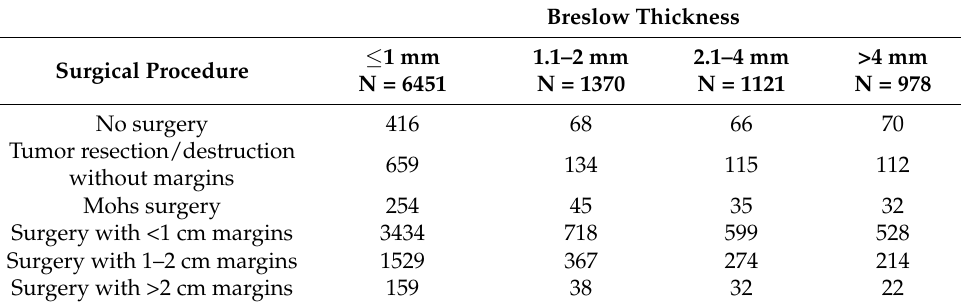
Table 2. Surgical procedures distribution according to Breslow